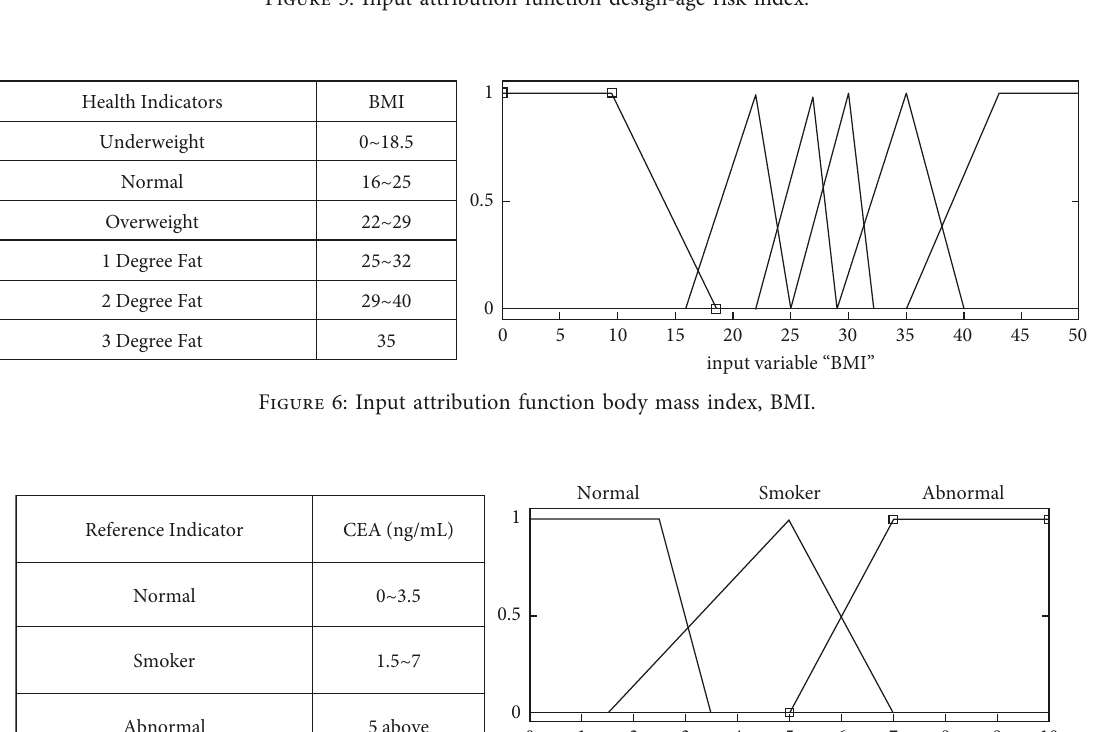
Figure 5: Input attribution function design-age risk index.